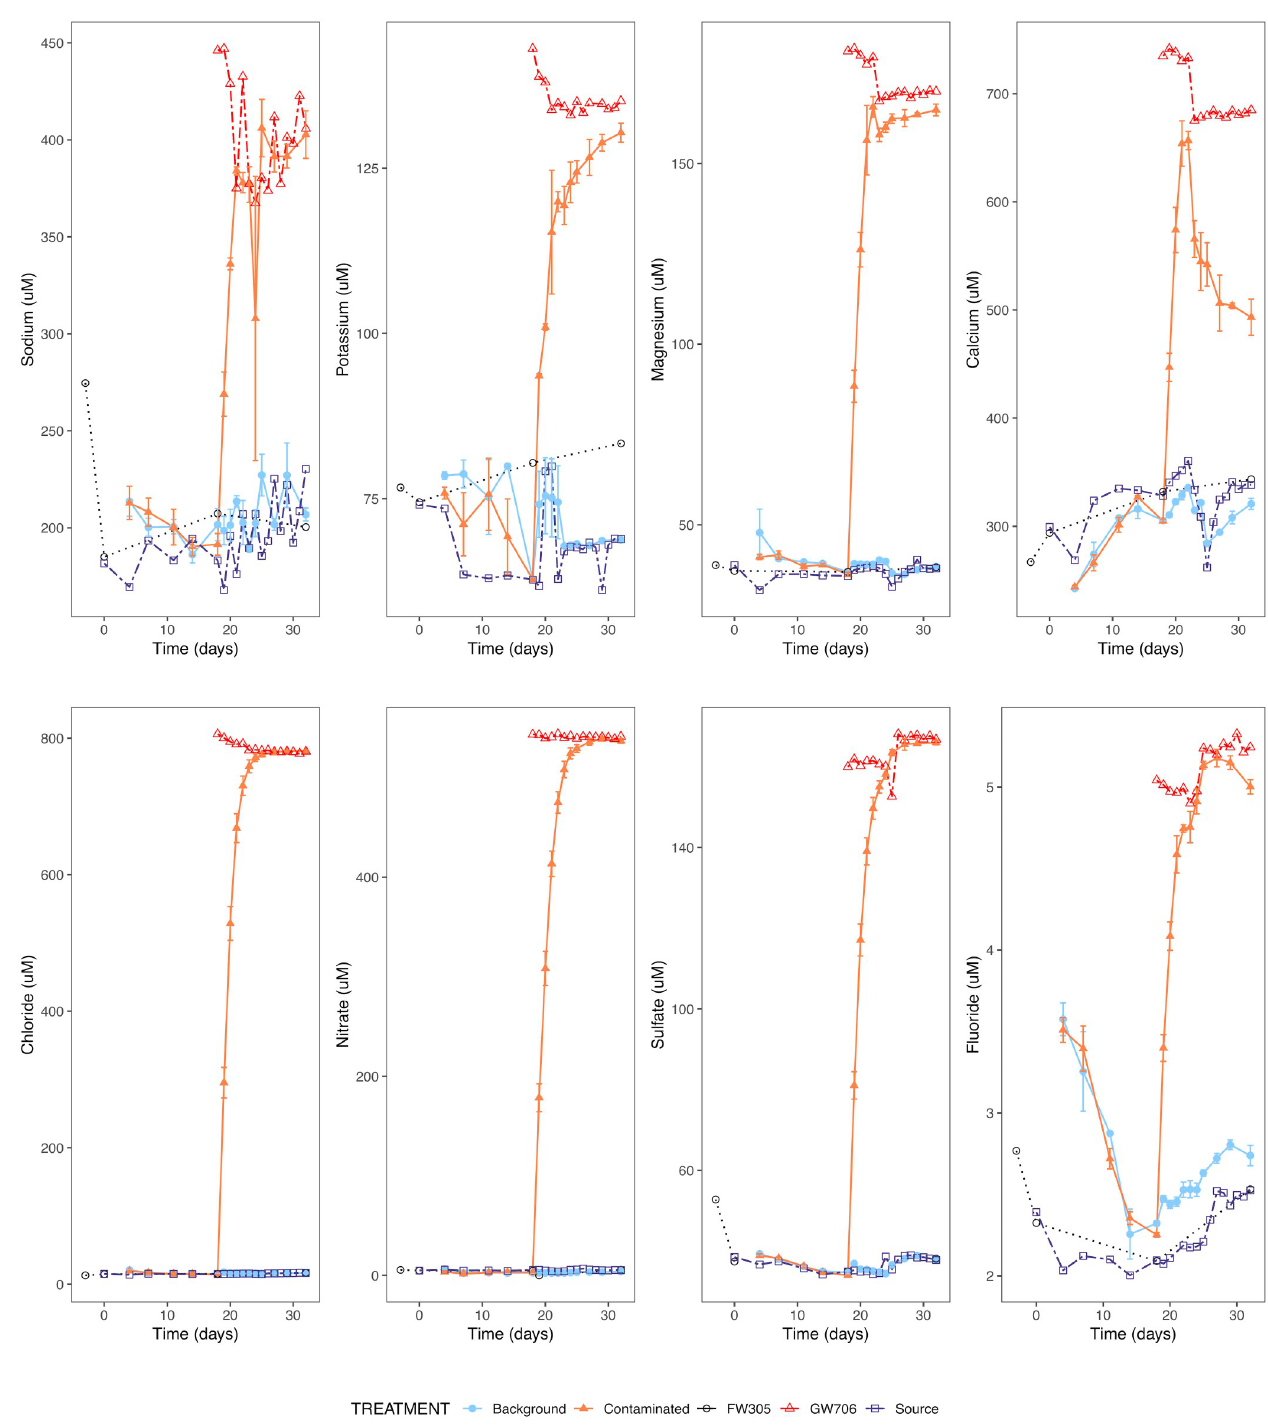
Fig 2. Major cation (top panel) and anion (bottom panel) concentrations in filtered water collected from bioreactors receiving background or contaminated water, groundwater from wells FW305 and GW706, and the source reservoir for the background reactors during duration of experiment. Error bars represent one standard